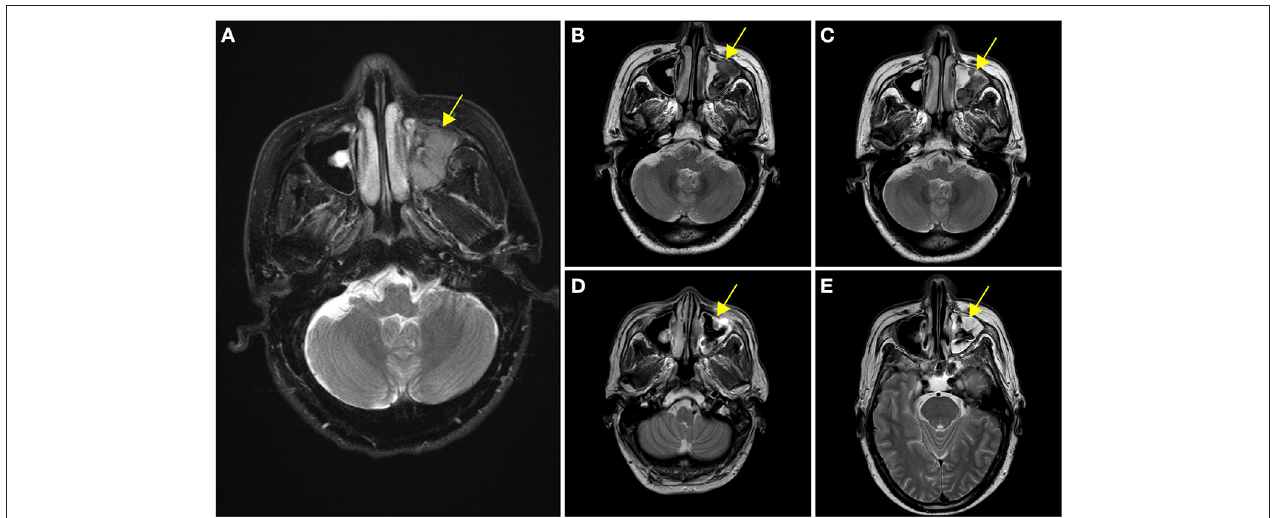
FIGURE 1 | Enhancement of nasopharyngeal MRI scanning at different stages of treatment. (A) Initial enhancement MRI scanning revealed heterogeneous enhancement shadow filling in the left maxillary sinus at diagnosis. (B) After two cycles of V-CDOP chemotherapy, enhanced MRI scanning showed an excellent initial response with a substantial decrease in the size and intensity of nasopharyngeal lesions. (C) After four cycles of V-CDOP, MRI scanning revealed no significant change. (D) After radiotherapy and two cycles of RV-CDOP, subsequent enhancement MRI scanning revealed a reduction in the size of nasopharyngeal lesion. (E) Repeated enhancement MRI scanning after autologous hematopoietic stem cell transplantation (ASCT) showed increased abnormal signal shadows in the maxillary sinus, which was considered an inflammatory reaction. The nasopharyngeal lesions were indicated by yellow